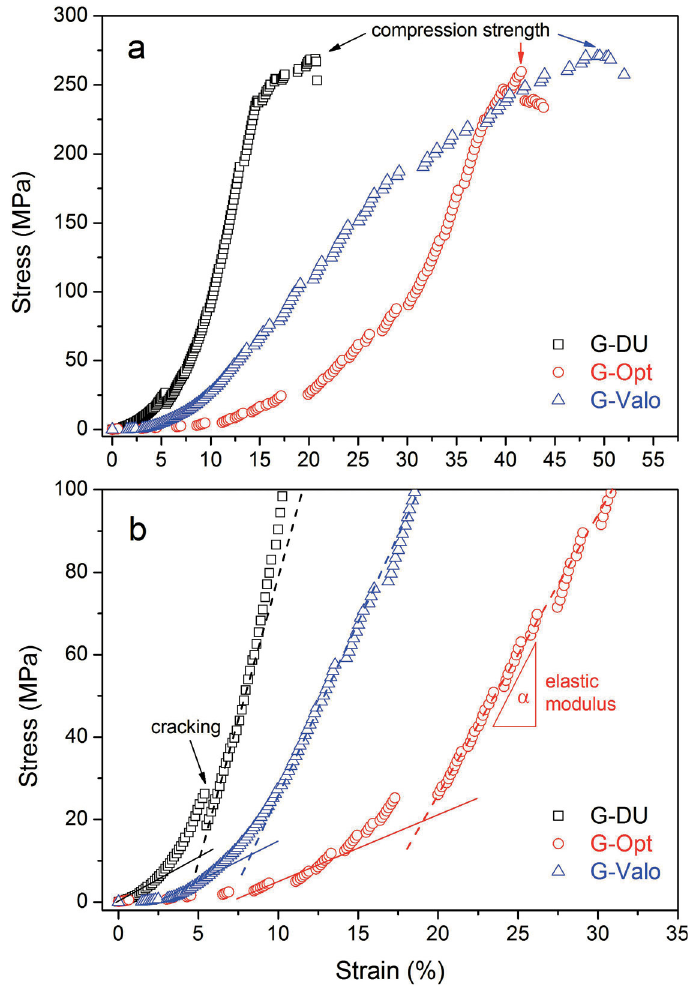
Figure 7- Representation of “stress-strain (SS) curves” of samples recorded during the compression test given in full SS range (a) and in initial elastic and transition region